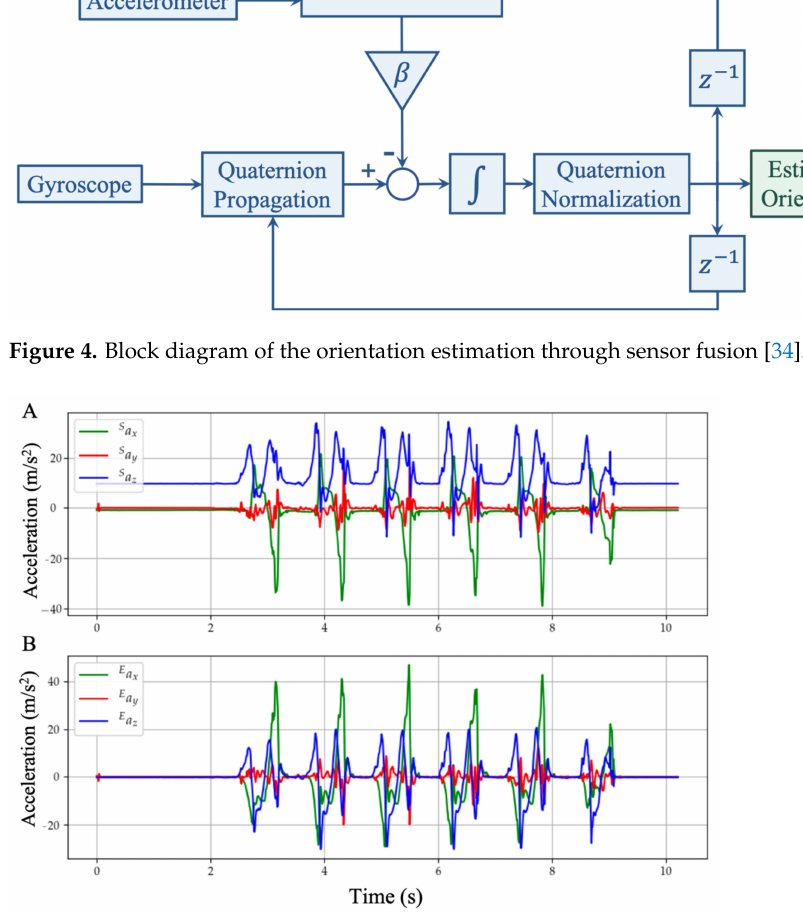
Figure 5. ( A ) Raw acceleration data measured in the sensor’s coordinate frame. By observing the initial stationary region, it can be deduced that the sensor’s resting position is not perfectly aligned with the ground (gravity has a slight projection onto the x and y axes). Gravity is affecting the readings of the linear accelerations and since the sensors are changing orientation it cannot be subtracted. ( B ) Transformed accelerations in the global coordinate frame. Since gravity is only projected in the global z axis, it can be directly